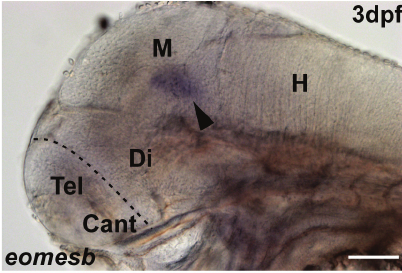
Figure S2. Expression of eomesb in the embryonic zebrafish brain. A . eomesb expression is not found in the telencephalon (T), but present in the midbrain (M), arrowhead, shown is a lateral view. Di Diencephalon, H Hindbrain.